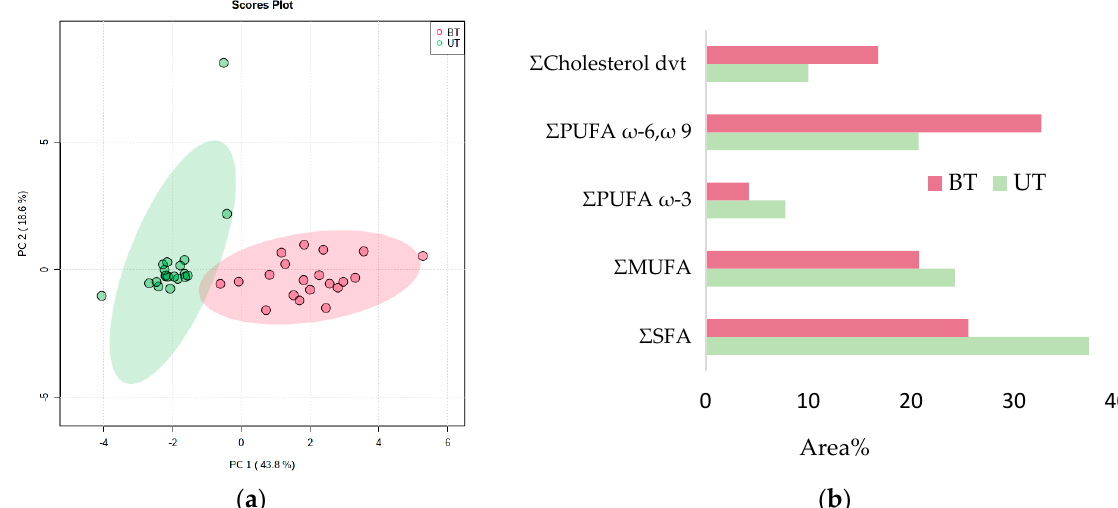
Figure 5. ( a ) PCA score plot. ( b ) % Area contribution of fatty acids per class for boar–tainted (BT) and untainted (UT) pig serum samples.